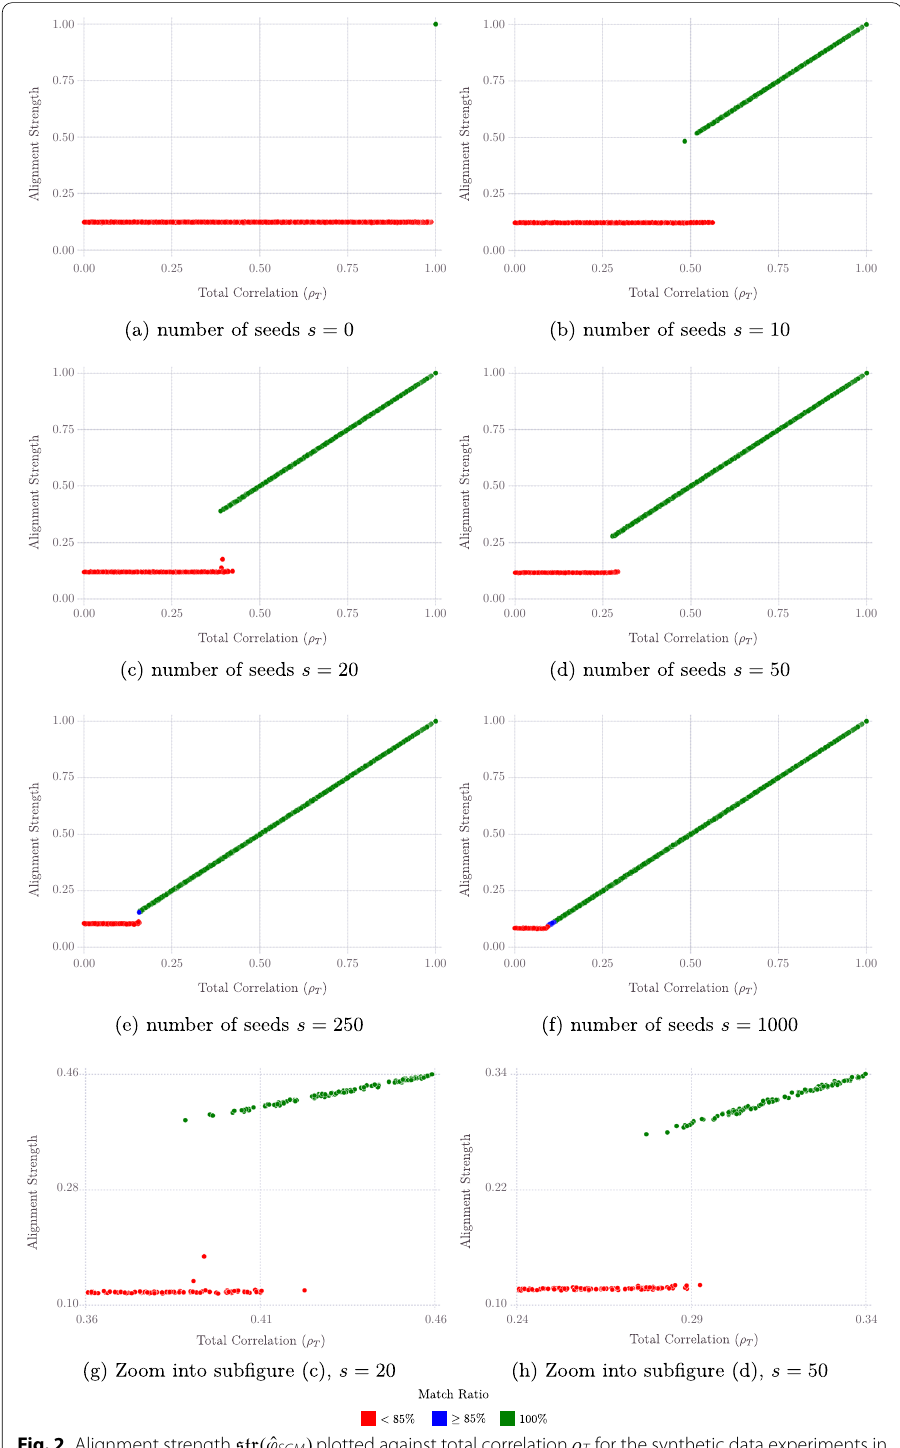
Fig. 2 Alignment strength str ( ˆ ϕ SGM ) plotted against total correlation ̺ T for the synthetic data experiments in Sect. “Of hockey sticks and broken hockey sticks”, separated according to the number of seeds s . The number of nonseeds was n = 1000 , and only the case of µ ′ = 0.5 is shown here. Match ratio of each experiment is color coded green, blue, or red according to the legend above. Subfigures g and h are zooms into subfigures c and d , to increase the granularity so that the thresholding is better